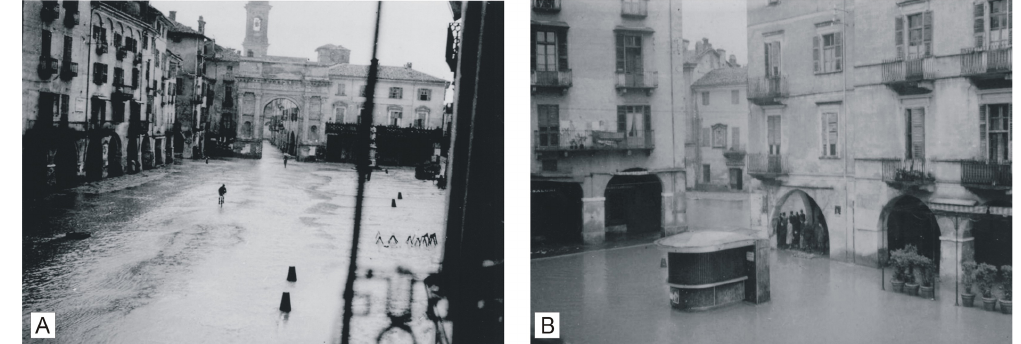
Fig. 7. South (a) and North-West view (b) of Piazza Santarosa in Savigliano historic centre. The square was flooded in May 1949. The red circle in Fig. 3 gives the location of the